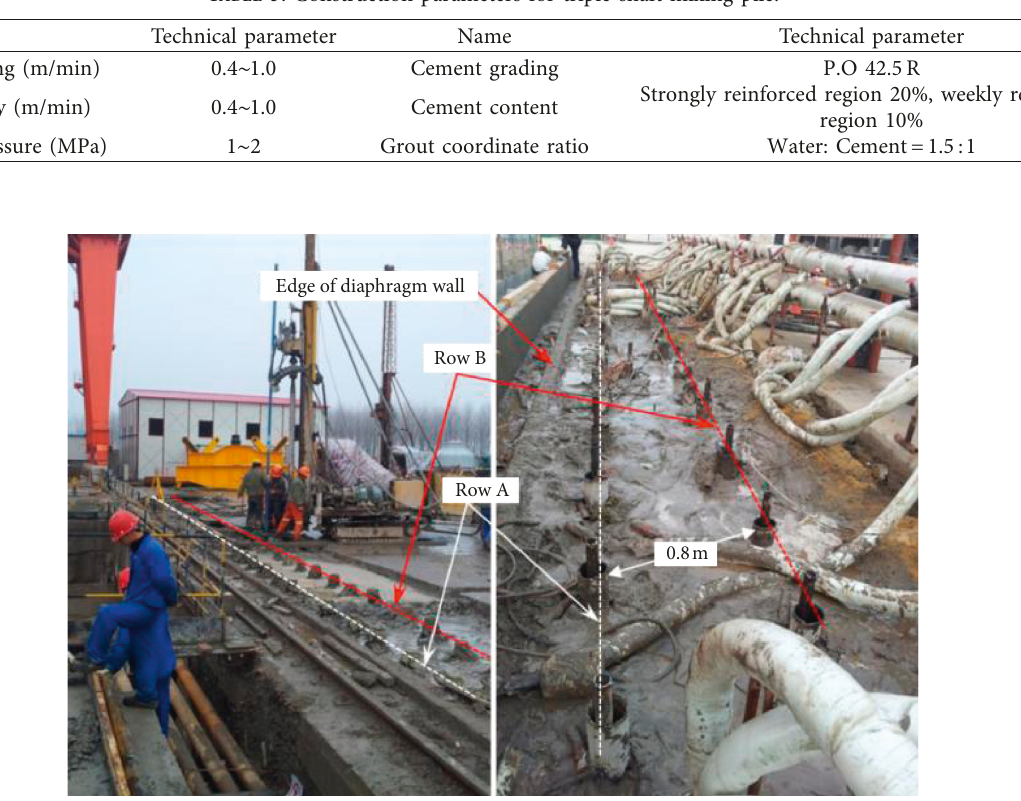
Figure 3: Layout of vertical freezing pipes.